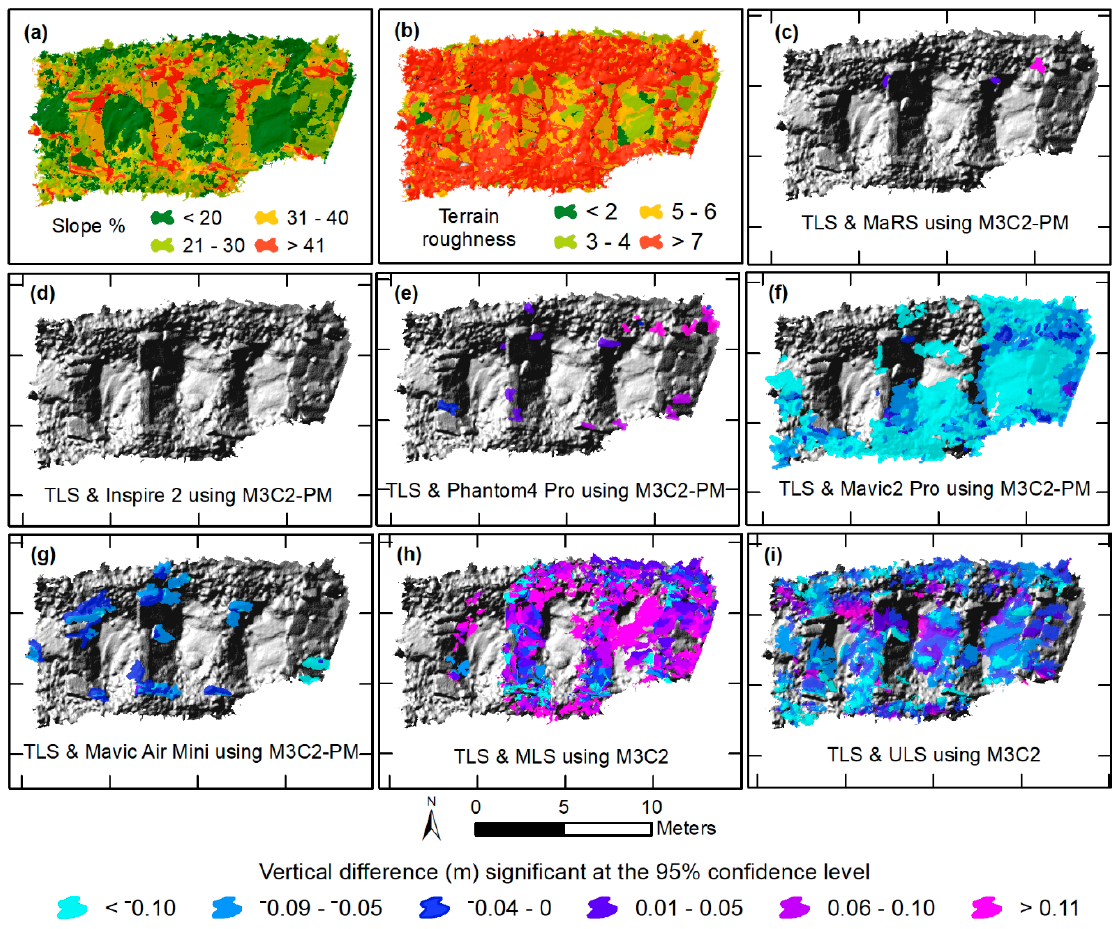
Figure 6. Object-based mean vertical differences of the original point clouds significant at the 95% confidence level between (1) terrestrial laser scanning (TLS) and SfM-based surveys using the M3C2-PM algorithm ( c – g ), and (2) TLS and mobile lidar system (MLS) ( h ), and TLS and unmanned lidar system (ULS) ( i ) using the M3C2 algorithm, all in meters. Object-based slope was determined using the TLS ( a ), and terrain roughness was determined using the standard deviation of the slope derived from the TLS ( b ). All objects are overlying a hill shade image.